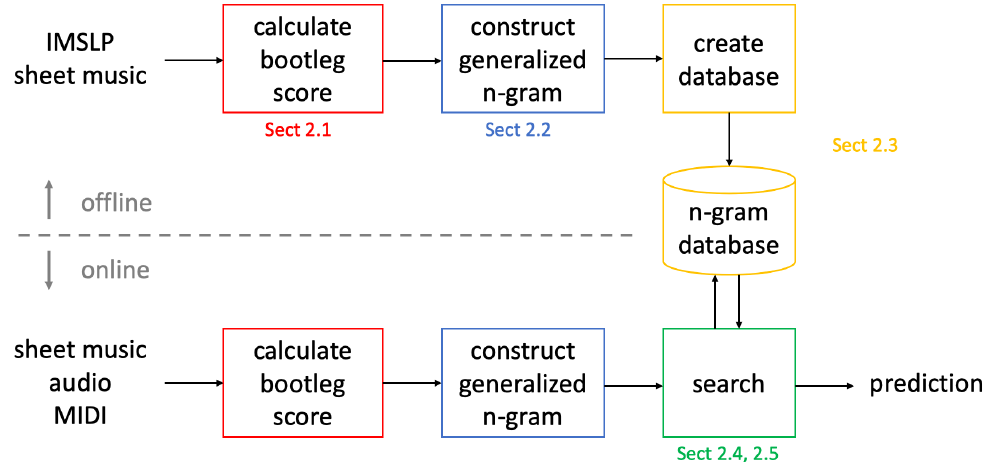
Figure 1. Overview of the marketplace fingerprinting approach for multimodal piano music identifi- cation. The input can be a sheet music image, an audio recording, or a MIDI